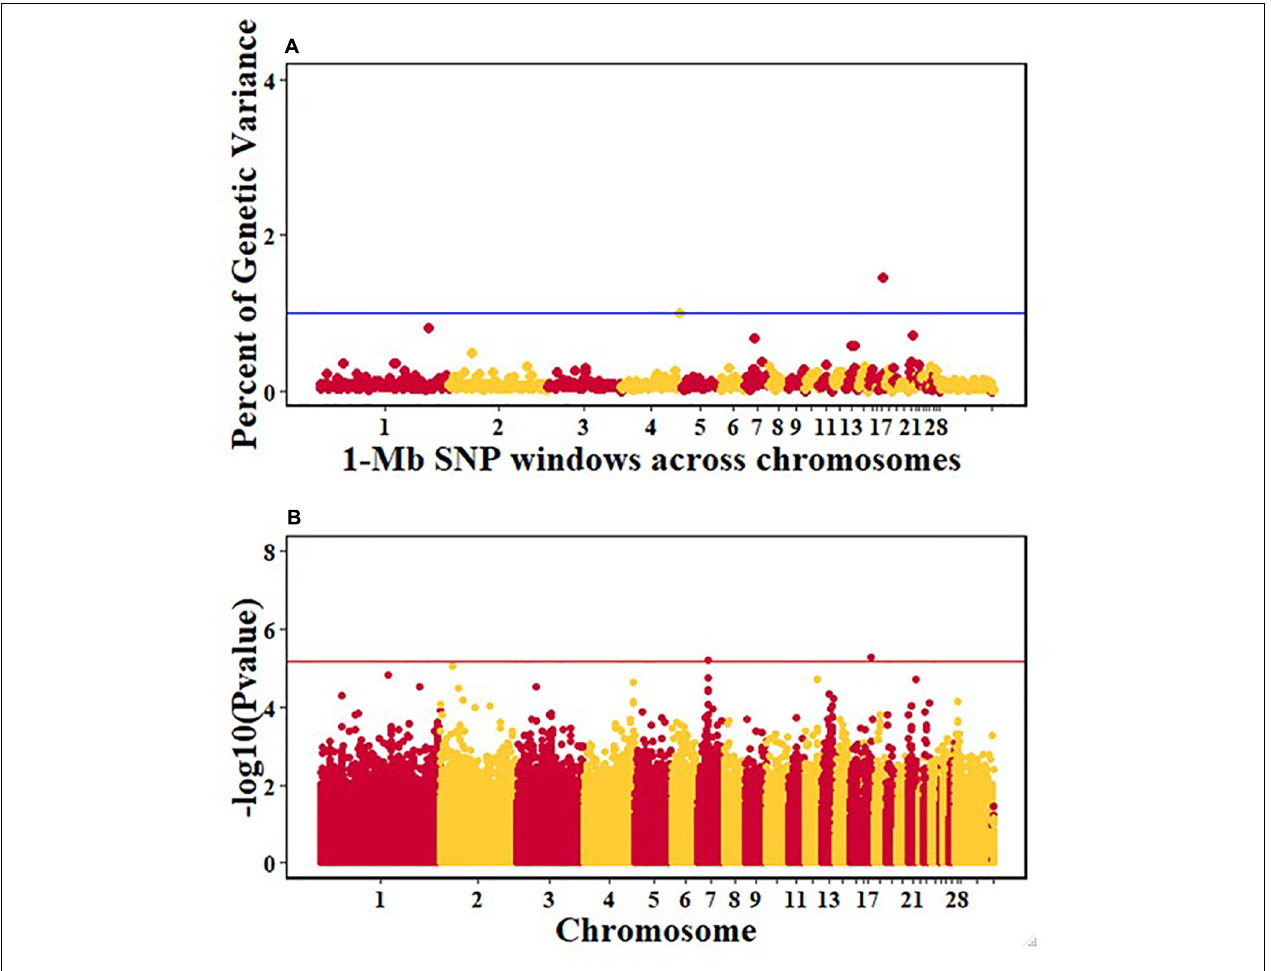
FIGURE 5 | Manhattan plots showing the genome-wide association results for antibody levels at 10 dpi in the Ghana local chicken ecotypes population, using Bayes-B and single-SNP analyses. (A) Bayes-B results showing the percent of genetic variance explained by SNPs in 1-Mb non-overlapping windows across chromosomes. (B) Single-SNP results showing the -log10(Pvalue) of ordered SNPs across the chromosomes. The blue and red lines indicate genome-wide significance at 1% genetic variance and 20% genome-wide suggestive association,